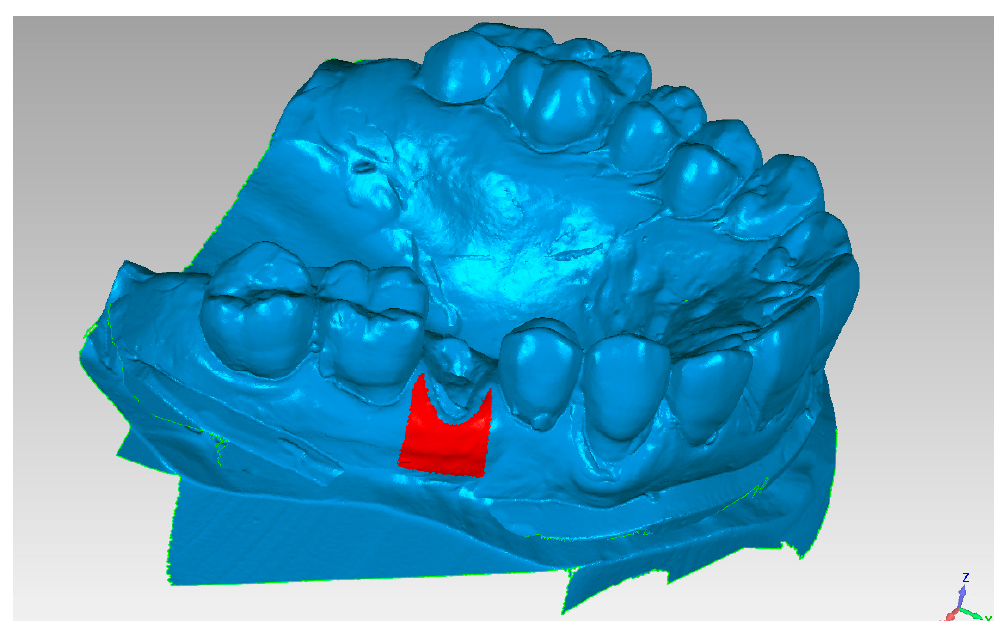
Figure 6. Area of analysis regarding vestibular volume variations.